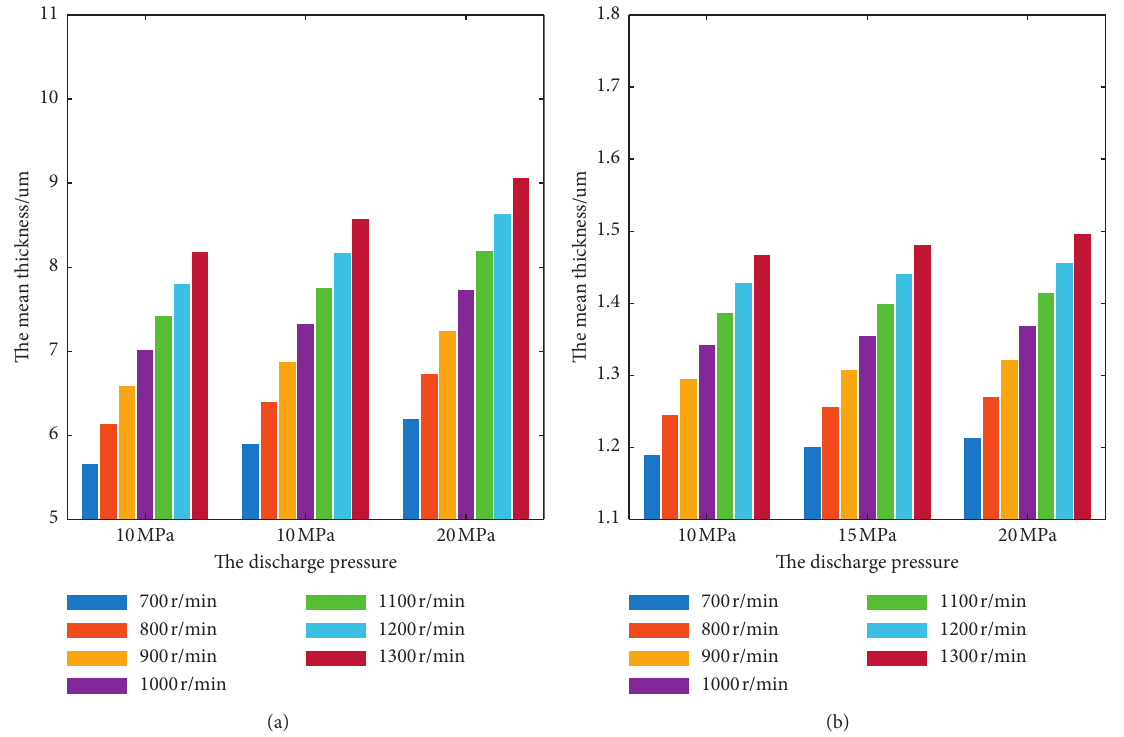
Figure 10: The mean value of the minimum thickness. (a) The discharge region; (b) the suction